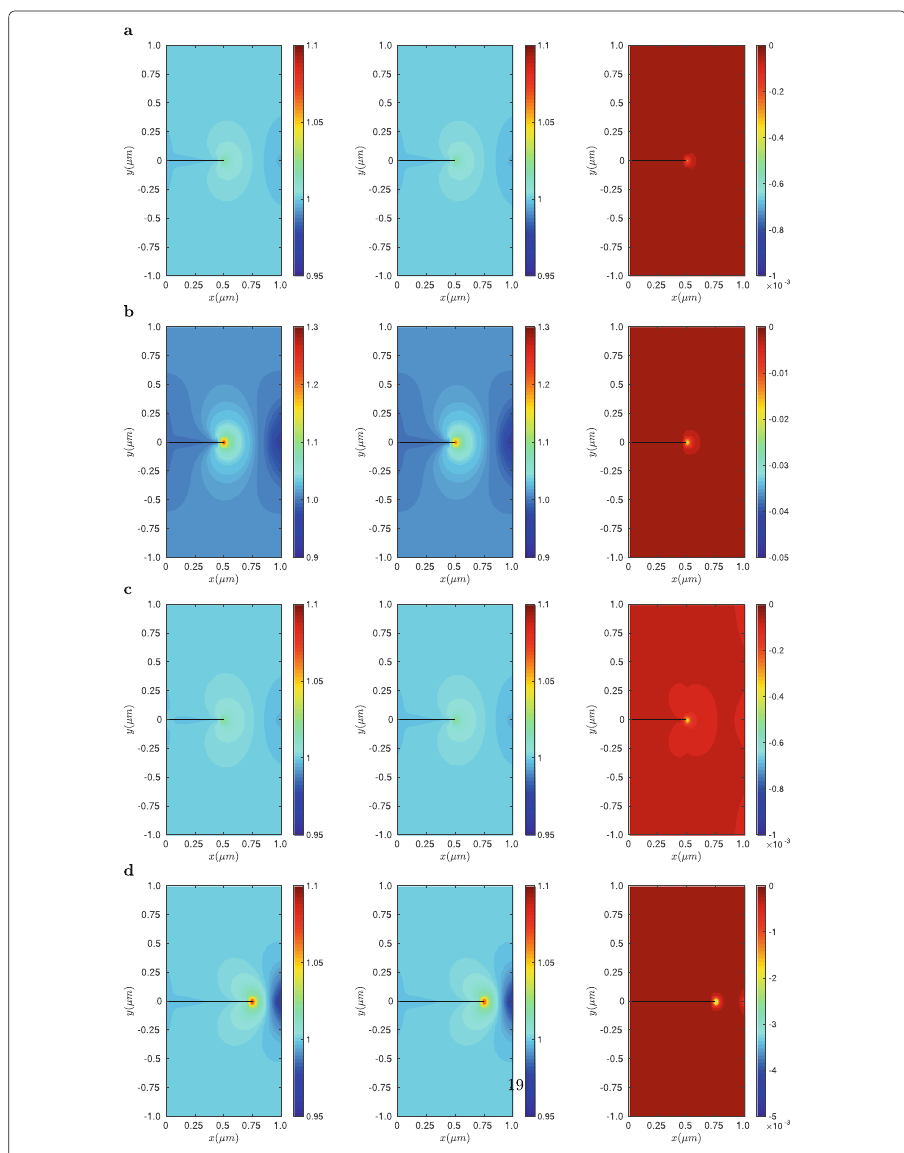
Fig. 11 Contours of the normalized H concentration χ/χ 0 as calculated from the benchmark numerical solution of Eq. (7) (left column) and from the linearized approximation given by Eq. (10) (middle column). The relative errors between both solutions are shown in the right column. The simulation parameters are: ( a ) = 0.001, L = 0.5 μ m, σ = 10MPa, ( b ) χ = 0.001, L = 0.5 μ m, σ = 100MPa, ( c ) χ = 0.01, L = 0.5 μ m, χ 0 c 0 0 c 0 0 c σ black line represents the crack